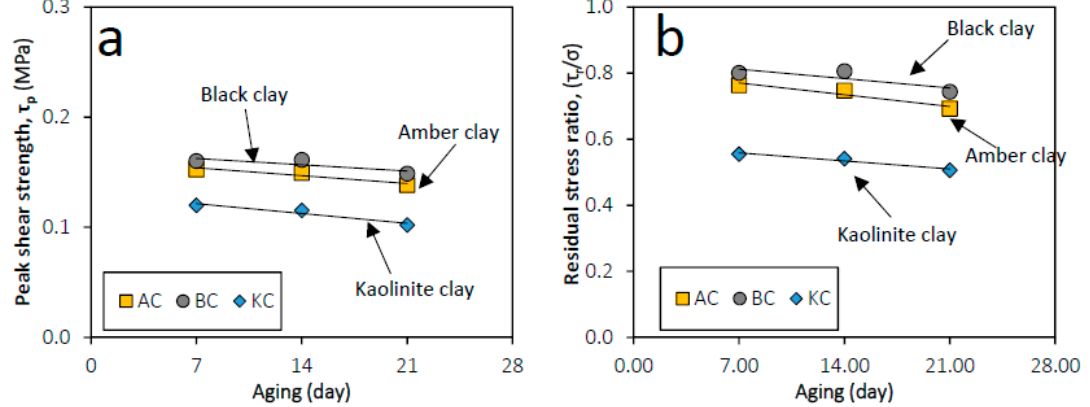
Figure 10. E ff ect of ageing of the atrazine contamination on AC, BC and KC specimens on ( a ) Peak Figure 10. Effect of ageing of the atrazine contamination on AC, BC and KC specimens on (a) Peak shear strength and; ( b ) residual stress shear strength and; (b) residual stress ratio.